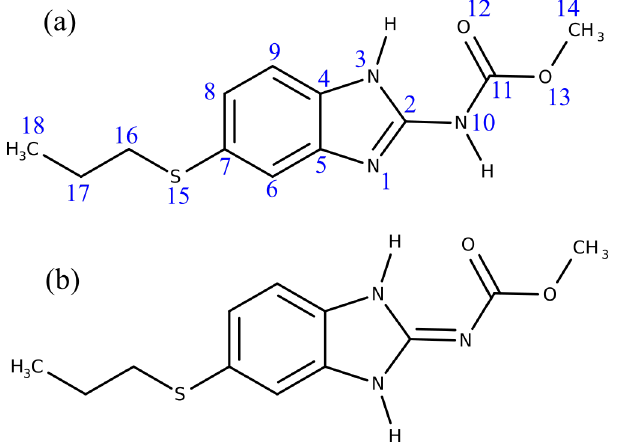
Figure 1. Tautomers of albendazole: ( a ) Form I; and ( b ) Form